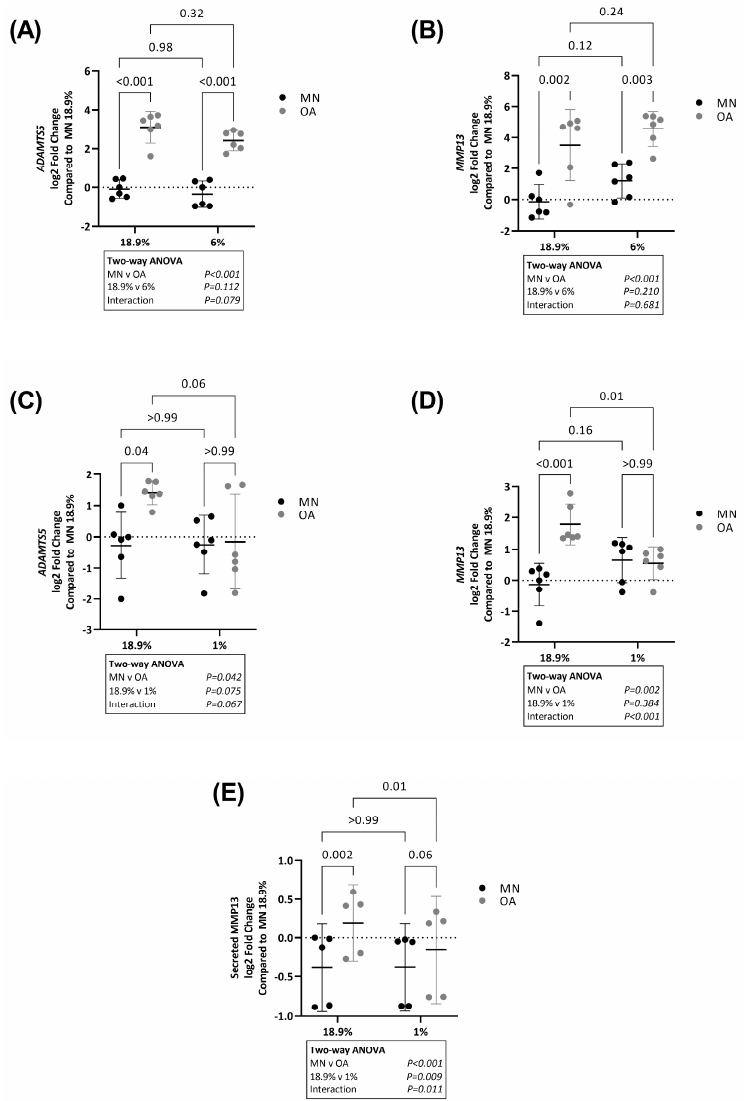
Figure 1. Expression of ADAMTS5 and MMP13 in OA chondrocytes and chondrocytes from macroscopically normal cartilage maintained in 18.9% compared to 6% or 1% oxygen. Paired samples of human chondrocytes isolated from macroscopically normal (MN) and osteoarthritic (OA) cartilage regions within OA joints from six patients were plated in duplicate plates. One plate was transferred to a standard tissue culture incubator (18.9% oxygen) for 24 h and the other transferred to a hypoxia incubator maintained at either 6% or 1% oxygen. Chondrocytes from a different six patients were used to compare the effects of 18.9% vs. 1% oxygen than those used to compare the effects of 18.9% vs. 6% oxygen. Comparison of RNA levels (measured by qPCR) of ( A ) ADAMTS5 and ( B ) MMP13 in cells maintained at 18.9% vs. 6% oxygen and ( C ) ADAMTS5 and ( D ) MMP13 in cells maintained at 18.9% vs. 1% oxygen. ( E ) Levels of secreted MMP13 protein as measured by ELISA in cell supernatants in chondrocytes from OA and MN cartilage maintained in 18.9% vs. 1% oxygen for 24 h ( n = 5). Data shown are mean ± 95% CI. All data were analysed by two-way ANOVA. Statistically signi fi cant di ff erences between groups following post hoc testing are shown on graphs. p < 0.05 was considered statistically signi fi cant.